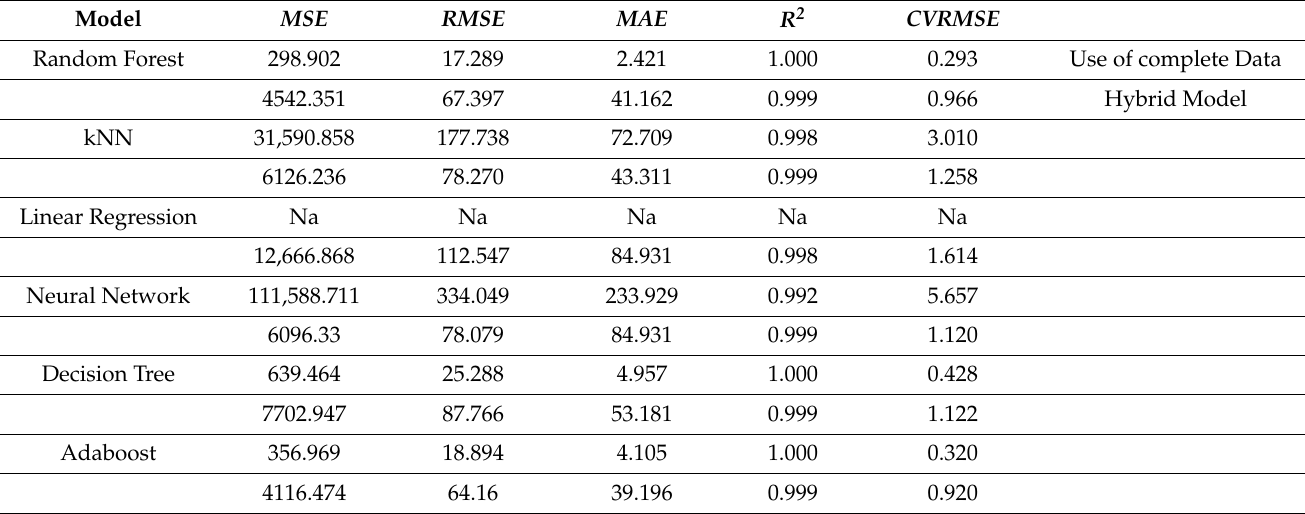
Table 2. Benchmark scores of the prediction algorithms using the complete data set and the hybrid model (modified data set).